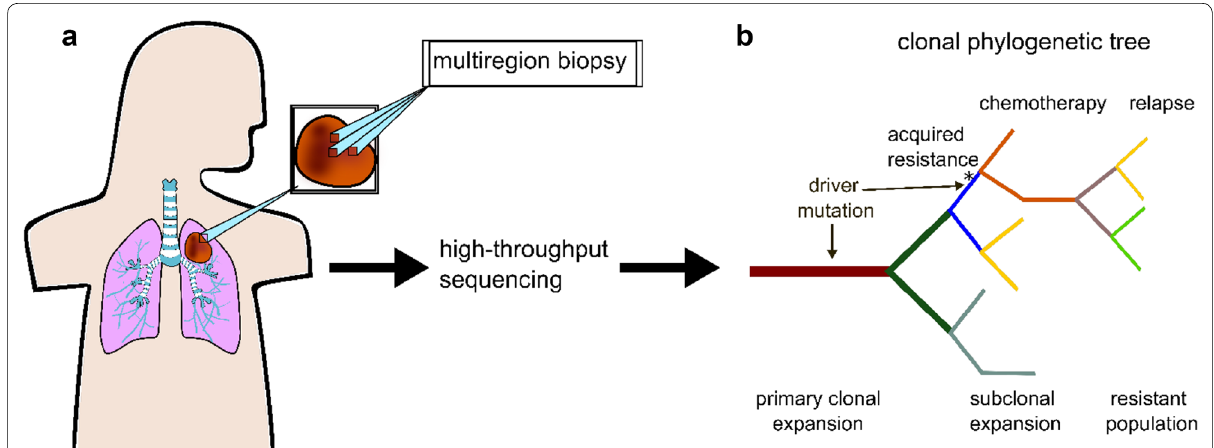
Fig. 2 Clonal phylogeny in cancer and resistance. A Darwinian tree model best describes clonal evolution. a Multiregion biopsies have been used to investigate intra-tumour heterogeneity. This involves taking biopsies from different regions of the same tumour then preparing high-throughput sequencing libraries. b Phylogenetic reconstruction of clonal evolution gives a detailed understanding of heterogeneity in the tumour. A muta- tion occurring at the ‘trunk’ of the tree and promotes clonal expansion. Subclones arise due to subsequent mutations that diversify the population. Driver mutations can also occur later in clonal evolution and infer resistant properties that were not present in the initial driver mutation. If chemo- therapy fails to knock out unique trunks, a drug-resistant population will remain and serve as the dominant feature during